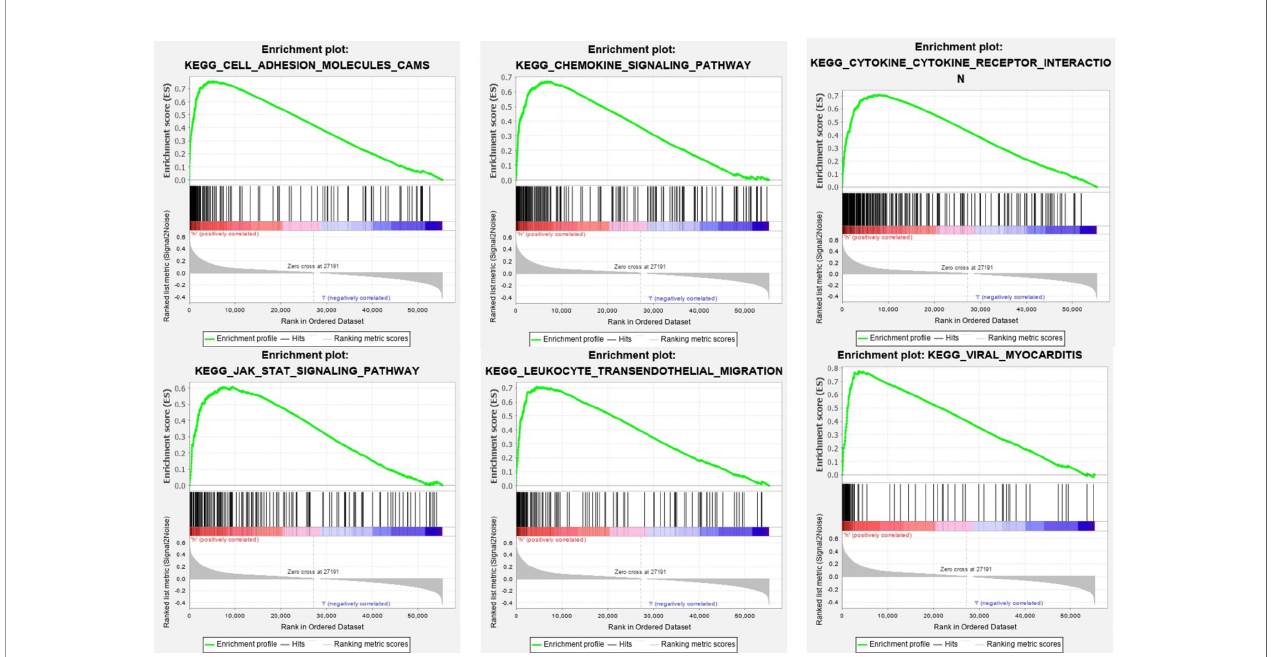
FIGURE 4 | Enrichment plots from GSEA. GSEA results showing differential enrichment of genes in lung cancer cases with high SOD3 expression, including adhesion molecules CAMS, chemokine signaling pathway, cytokine-cytokine receptor interaction, JAK stat signaling pathway, leukocyte transendothelial migration and viral myocarditis.